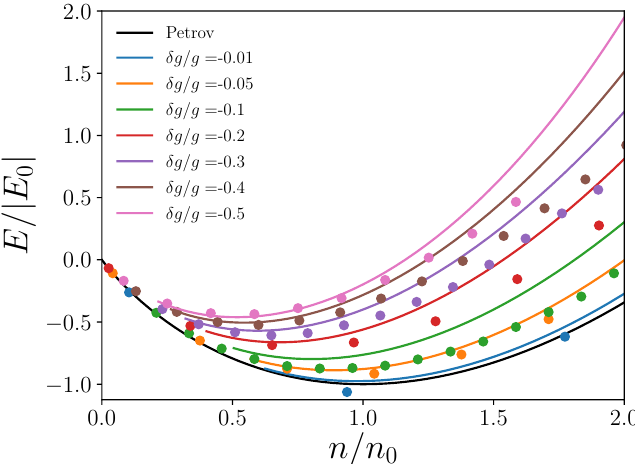
Figure 3: Equation of state in units of the equilibrium density (13) and energy (12), for different values of δ g / g . The lowest black solid line is the universal result from Ref. [ 3 ] . The color solid lines are the predictions from the beyond LHY theory, while the color dots are QMC results from Ref. [ 11 ] .